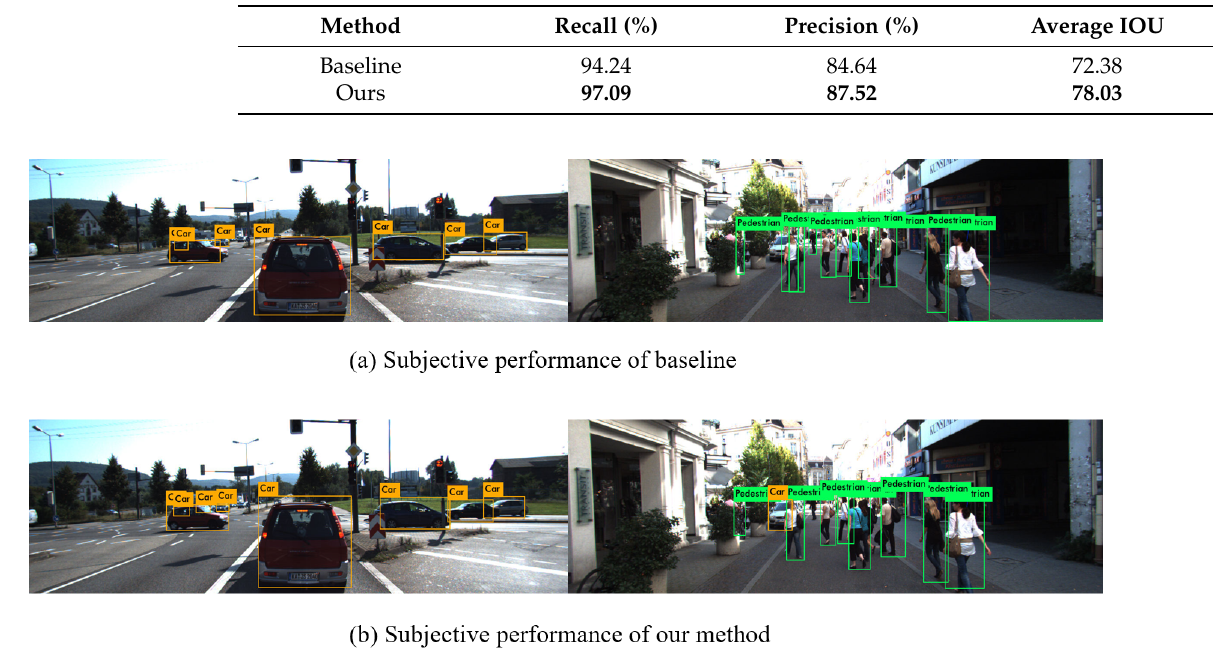
Figure 8. Comparison of detection effects between baseline and our